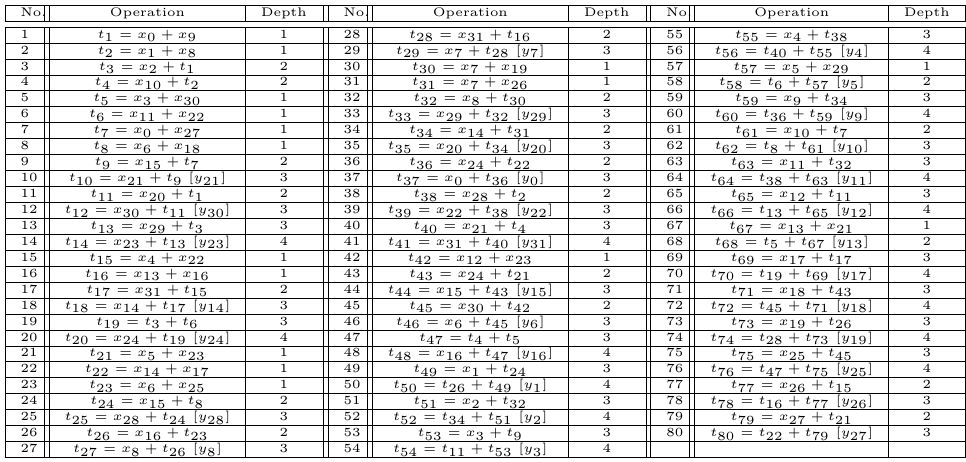
Table 2: An implementation of G with 80 XOR gates and depth 4, where ( x 0 , · · · , x 31 ) are input signals, ( y 0 , · · · , y 31 ) are output signals, and t i ’s are intermediate